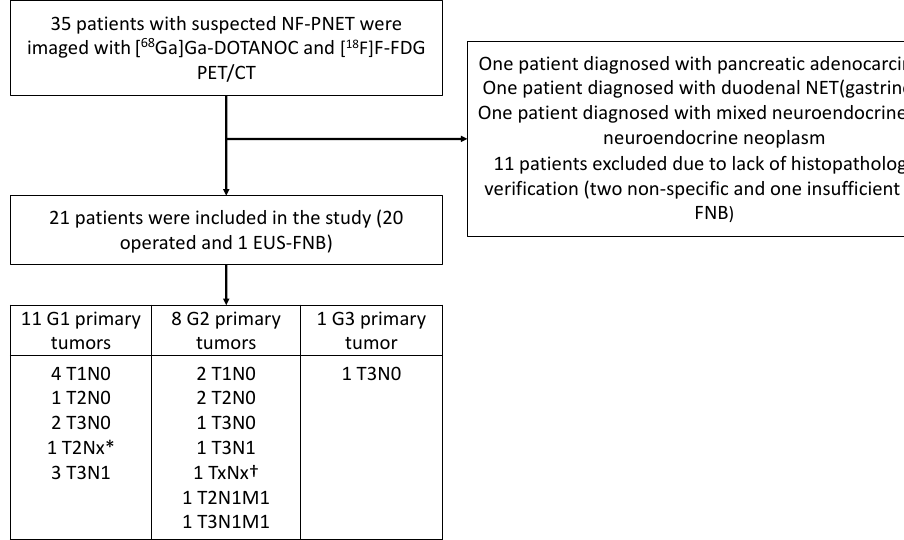
Figure 1. Flowchart of the recruitment and imaging of the patients and final histopathological findings (grade and stage) of the tumors. EUS-FNB, endoscopic ultrasonography and fine-needle biopsy. * Unknown lymph node status due to enucleation. † Diagnosis was made by biopsy, stage unknown. Twenty-one patients had a total of thirty-five histologically confirmed tumors, of which twenty-eight lesions were detectable upon PET/CT imaging. The median PET/CT imaging interval was 34 days (d) (IQR 9–76.5 d). In histopathological examination, six patients had Table 1. Patient Characteristics. stage I disease, seven had stage II disease (three IIA and four IIB), four had stage III disease, and two had stage IV disease (shown in Figure 1). Six patients had histologically verified lymph node metastases. The median primary tumor size of these patients was 49.5 mm (IQR 30.8–78.8 mm, range 24–90 mm), whereas the median tumor size of all patients was